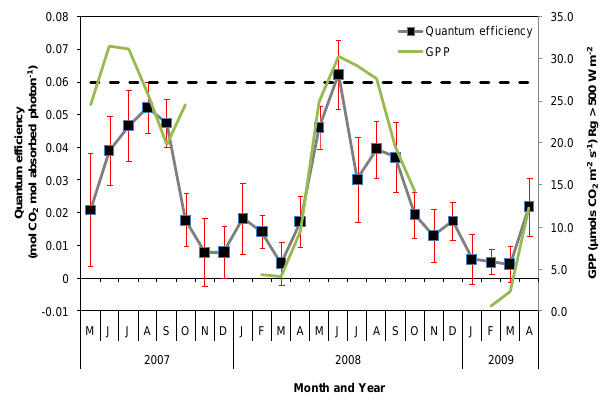
Fig. 8. Variation of quantum efficiency and GPP under high light (solar radiation > 500Wm − 2 ), calculated from monthly data (the- oretical maximum quantum efficiency is also